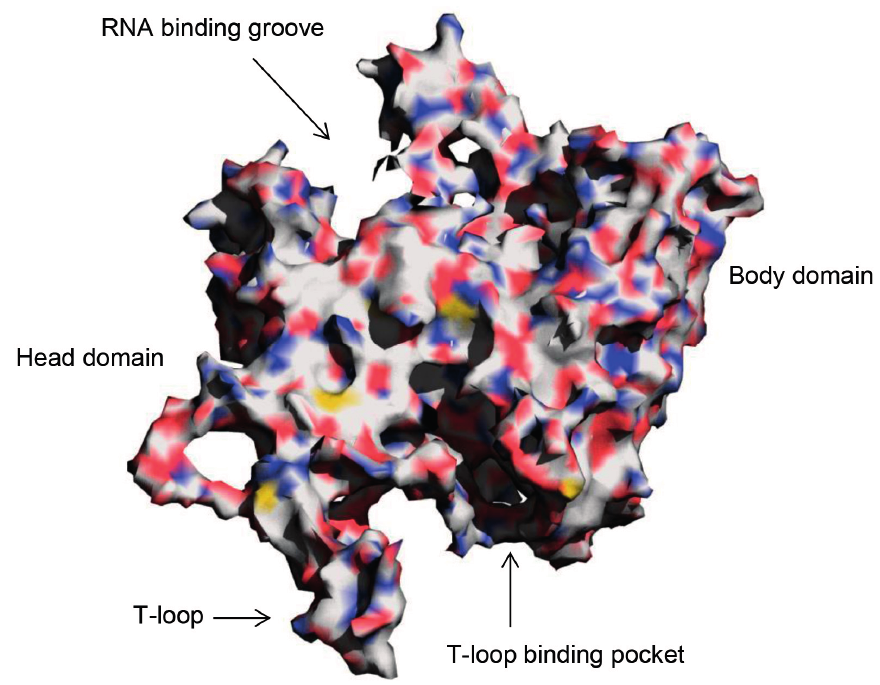
Figure 1. Surface representation of H1N1 Influenza A nucleoprotein (NP) monomer showing the head and body domains, T-loop, T-loop binding pocket and the RNA binding